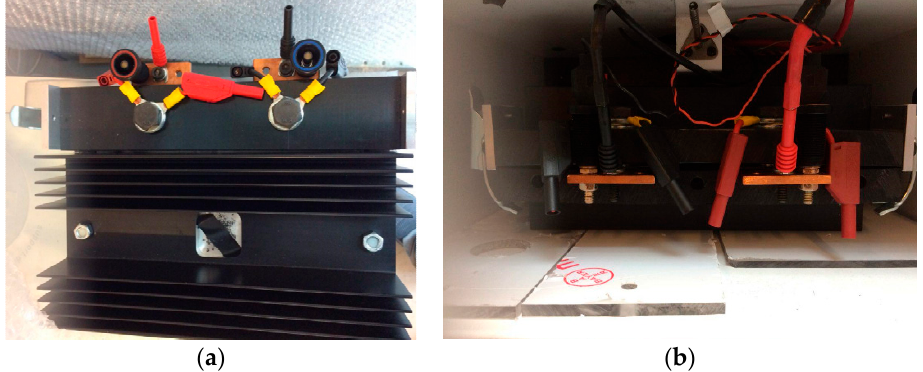
Figure 1. 13 Ah pouch type commercial lithium-ion battery cell. ( a ) The battery cell inside fixture. ( b ) The battery cell and fixture inside the Maccor chamber.